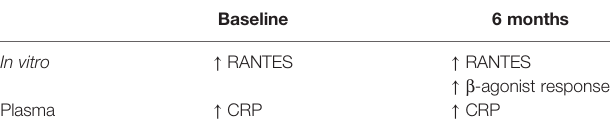
TABLE 4 | Summary of fi ndings in the EBV CF+ patient